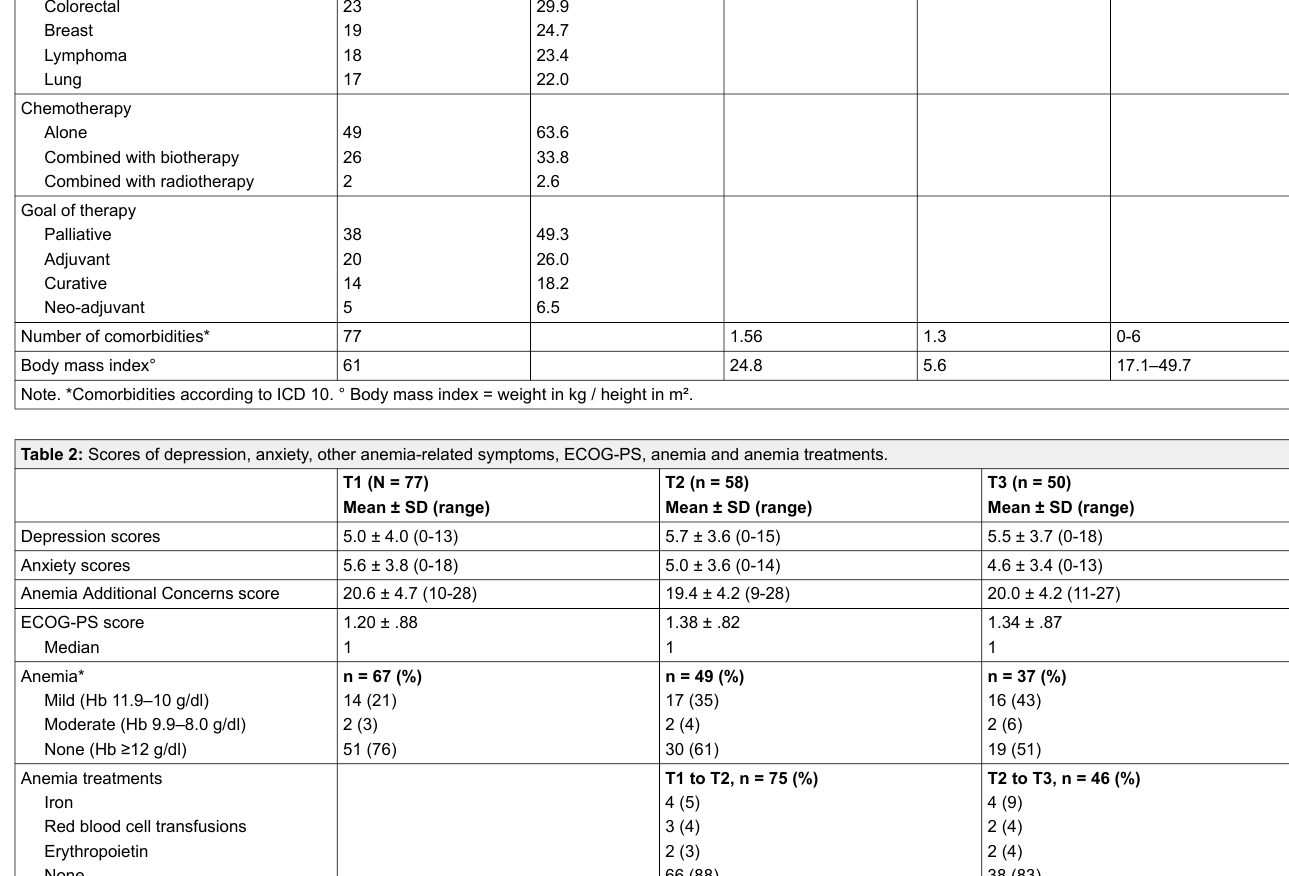
Table 1: Demographic and clinical characteristics of participants. Patient characteristics